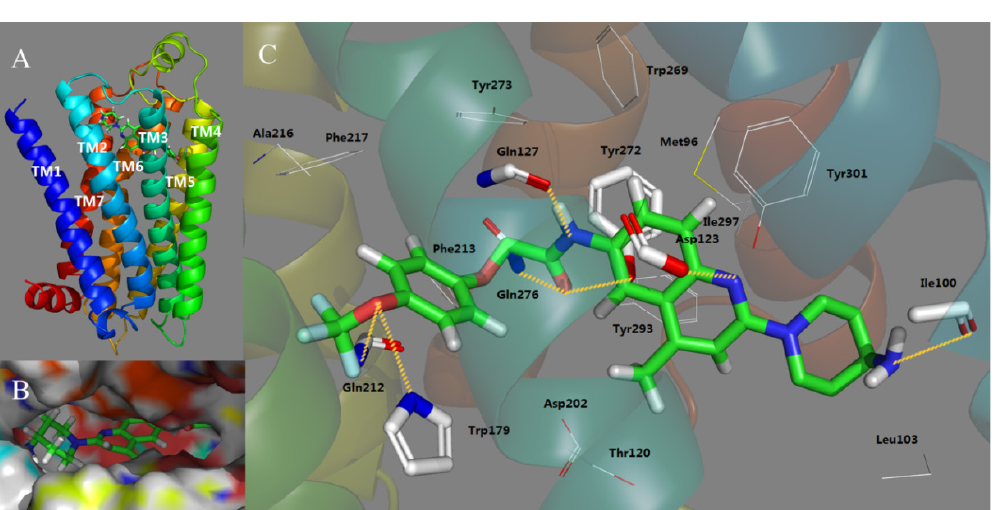
Figure 5. The binding mode of Compound 169 docked in MCHR1. ( A ) The overview of the docking conformation; ( B ) The cavity that the ligand fits into and the conformation of 169 in the entrance position; ( C ) The binding interactions of Compound 169 with amino acids of MCHR1. highlighted with green and white carbons, respectively. Hydrogen bonds and salt bridges are shown as yellow dashed lines. Atoms O and N are colored red and blue,